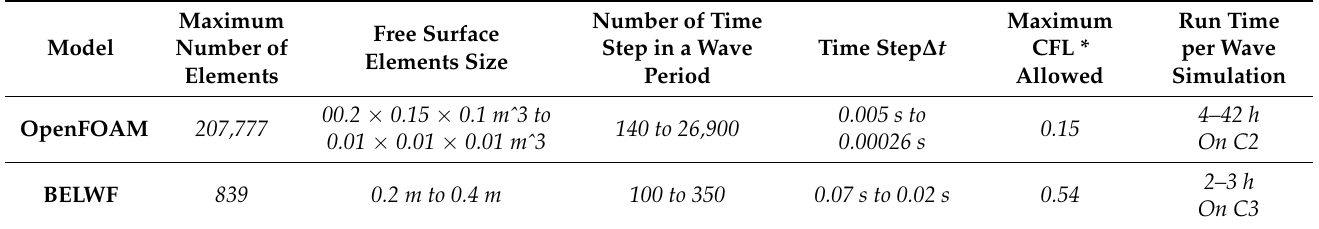
Table 1. Numerical parameters of all the applied models for the validation